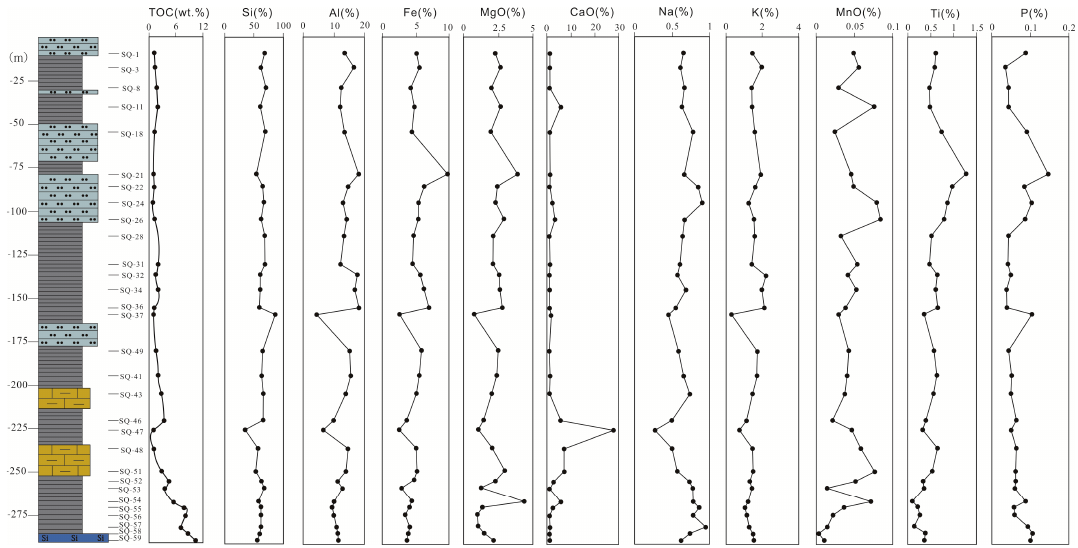
Figure 3. Vertical variation of major elements of the samples in SQ-1.